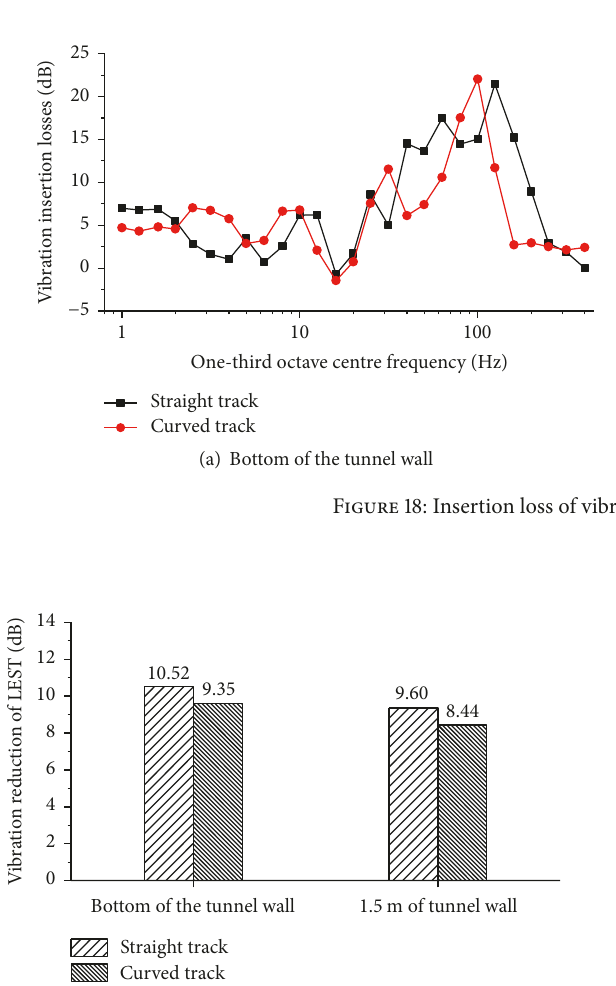
Figure 19: Comparison of overall vibration level